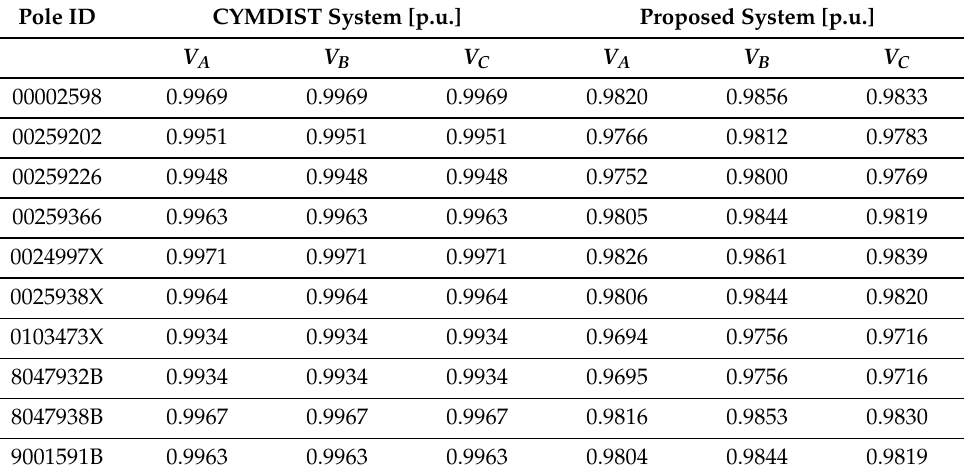
Table 7. Results comparison between the Proposed System × CYMDIST system in feeder- β . Pole